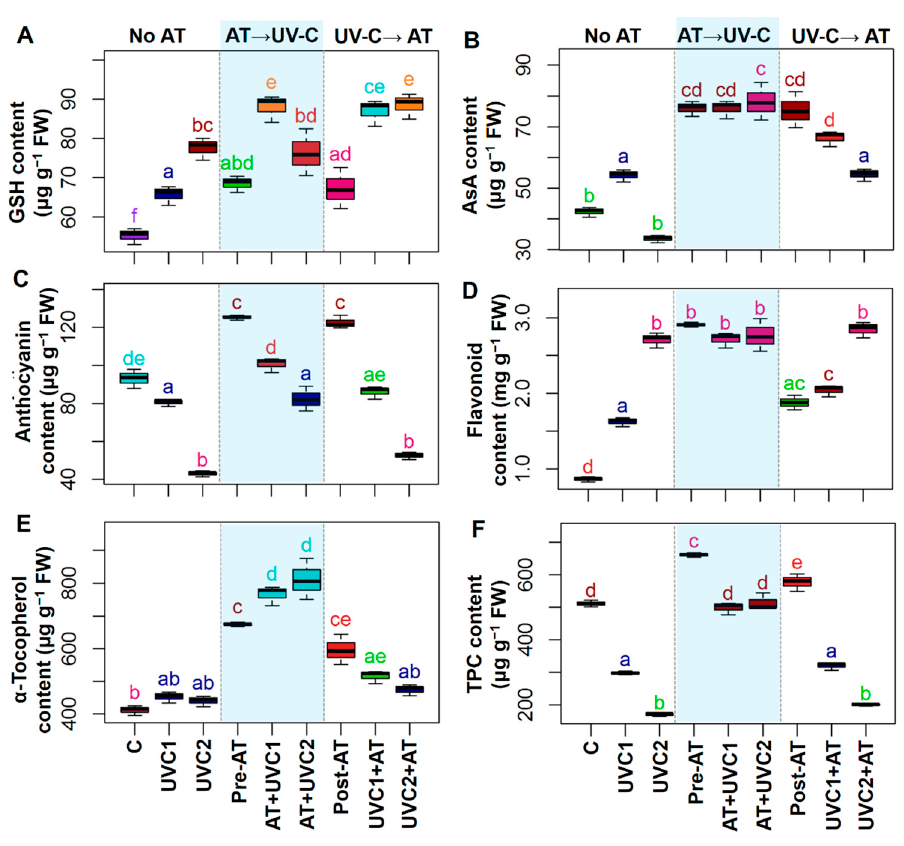
Figure 3. Effects of pre-treatment and post-treatment of allantoin (AT) on glutathione (GSH) ( A ), ascorbic acid (AsA) ( B ), anthocyanin ( C ), flavonoid ( D ), α -tocopherol ( E ), and phenolic compounds (TPC) contents ( F ) in tomato plants grown 15 days in presence and absence of UVC stress. Each boxplot shows values of five independent replicates ( n = 5). Boxplots specified with the same letter(s) are statistically non-significant at p < 0.05 based on Tukey’s test. Treatments are the same as Figure 1.